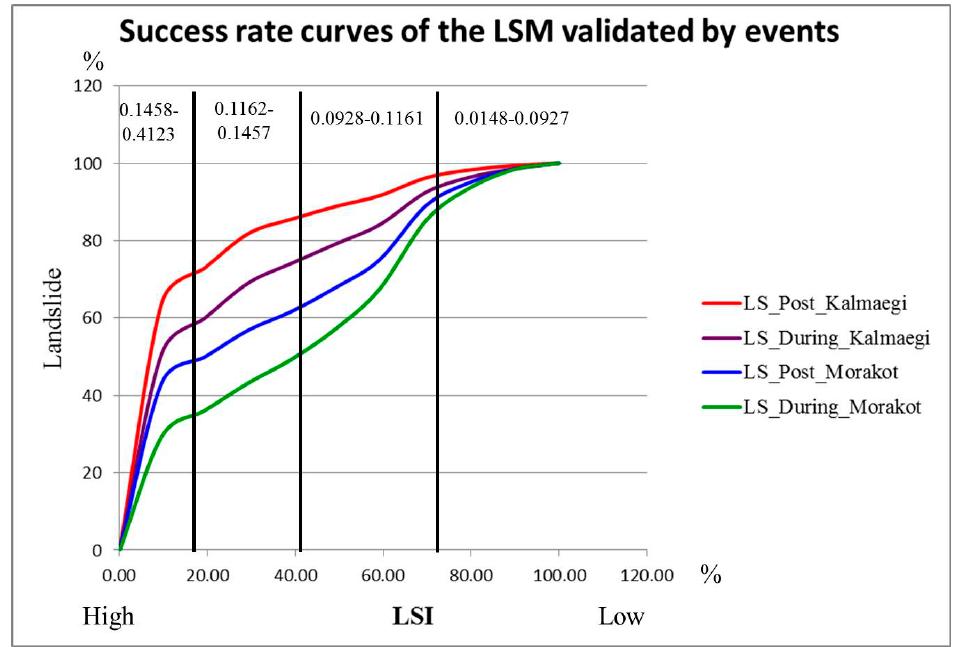
Figure 9. The success rate curves (landslide cumulative) of the LMs of events (Typhoon Kalmaegi and Typhoon Morakot).